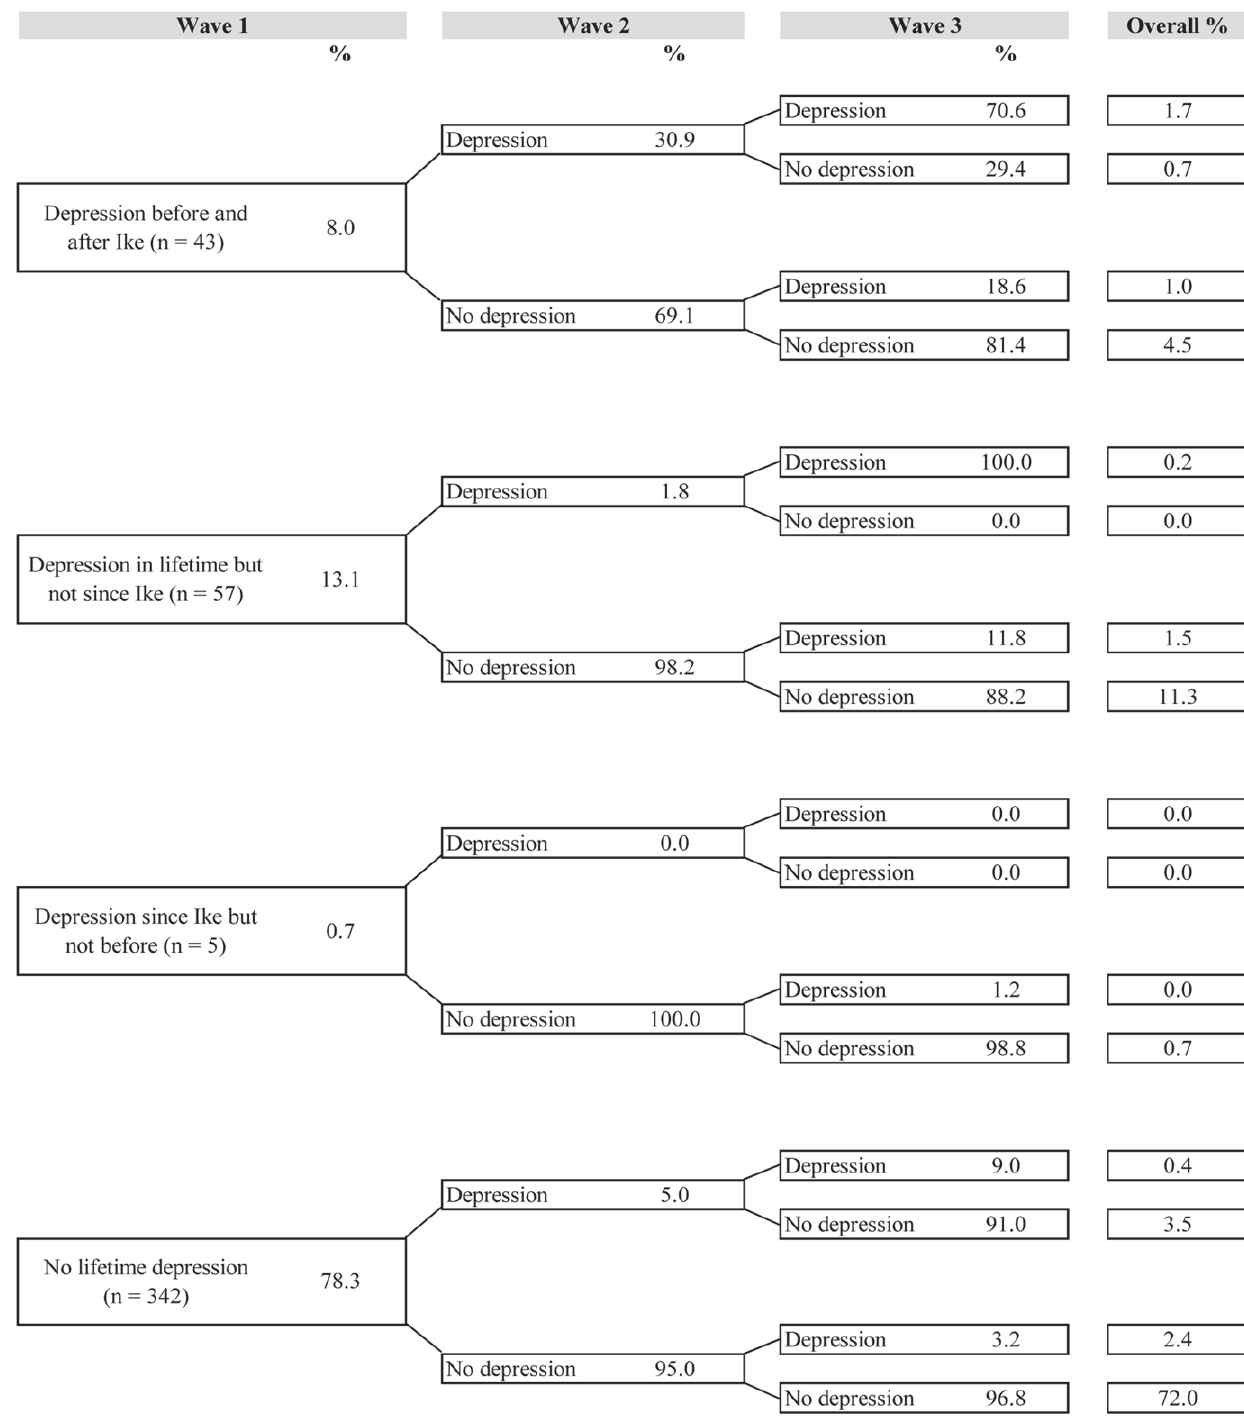
Figure 4. Trajectories of depression (n=448).